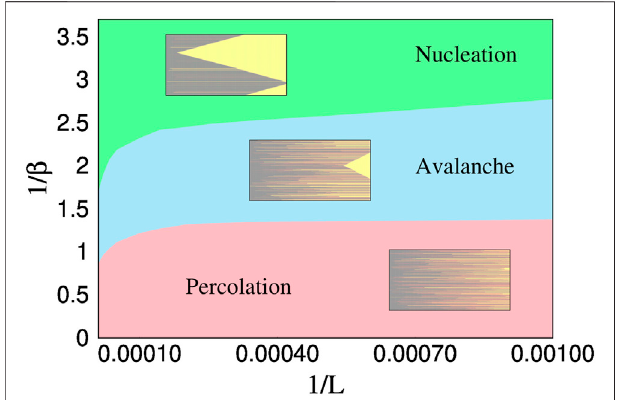
FIGURE4| Phasediagramofdisorderstrength β andsystemsize L .1/ β isplottedagainst1/ L tomakethecoordinate(0,0)representin fi nitedisorderat thermodynamic limit. Three regions − nucleation, avalanche and percolation are observed. The spatial correlation during fi ber rupture is shown with yellow being the broken